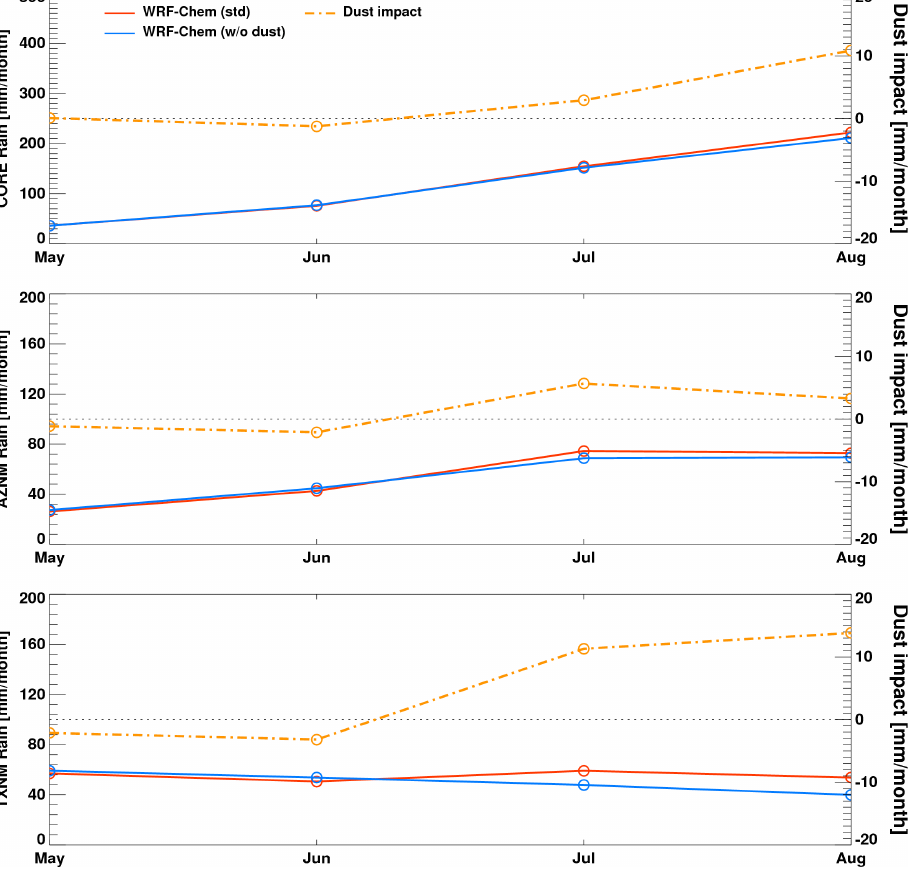
Fig. 10. Monthly precipitation and dust-induced change averaged over the three NAM sub-regions (CORE, AZNM, and TXNM) from the Figure 10 Monthly precipitation and dust-induced change averaged over the three NAM 8 WRF-Chem simulations for May–August, sub-regions (CORE, AZNM, and TXNM) from the WRF-Chem simulations for May-9